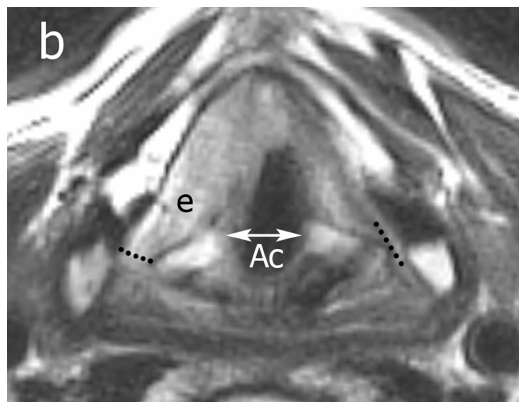
Figure 3. Example of Pattern B. From top to the bottom: ( a ) TSE-T2 on coronal plane; ( b ) TSE-T2 on axial plane. A right glottic tumor that does not invade the posterior laryngeal compartment (PLC) is seen. In ( a ), normal signals of lateral cricoarytenoid and cricothyroid muscles are displayed, the cricoid lamina is normal, and an inferior paraglottic space (PGS) is indicated by dotted lines. In ( b ), expansion of the right PLC (dotted black lines) is seen. A high T2 signal in the PLC is consistent with an intense edema that hampers crico-arytenoid unit (CAU) functionality. Legend: Ac, arytenoid cartilages; CL, cricoid lamina; ctm, cricothyroid muscle; e, edema; lcam, lateral cricoarytenoid muscle.